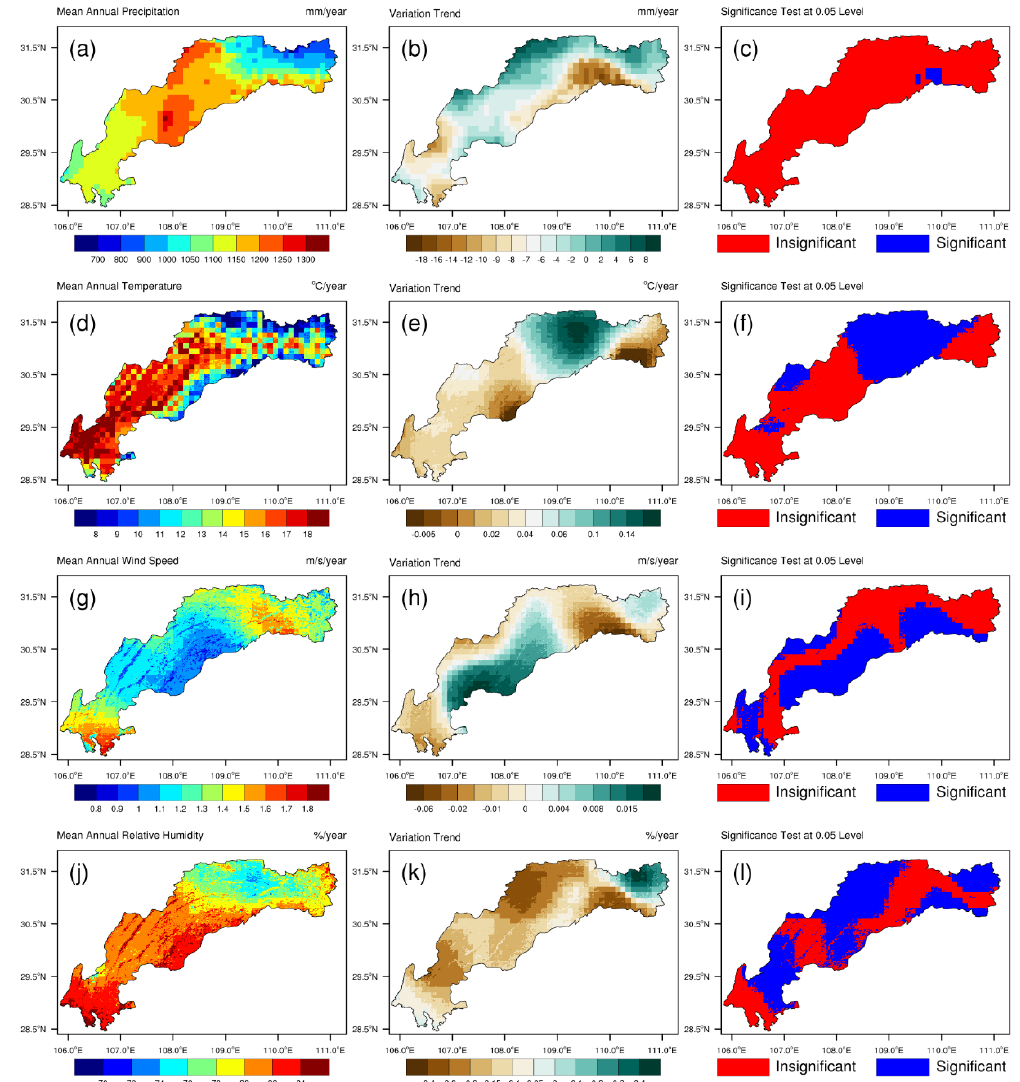
Figure 4. The spatial distribution and variation trends of annual climatic factors.